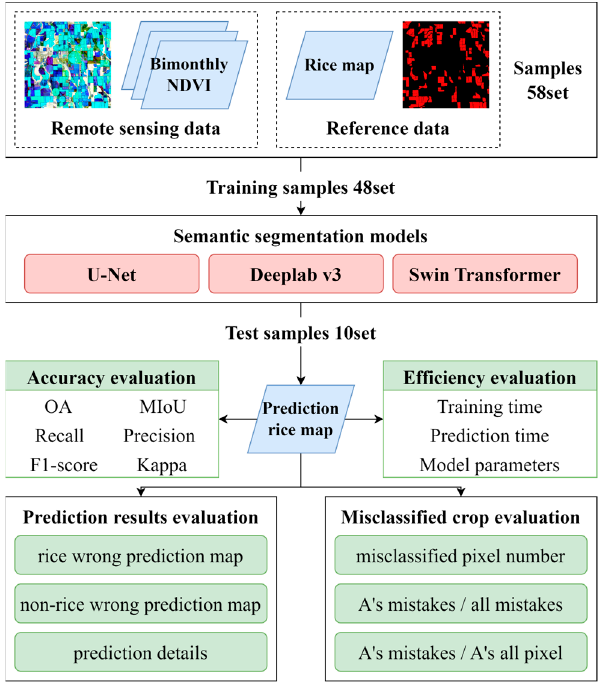
Figure 4. Evaluation